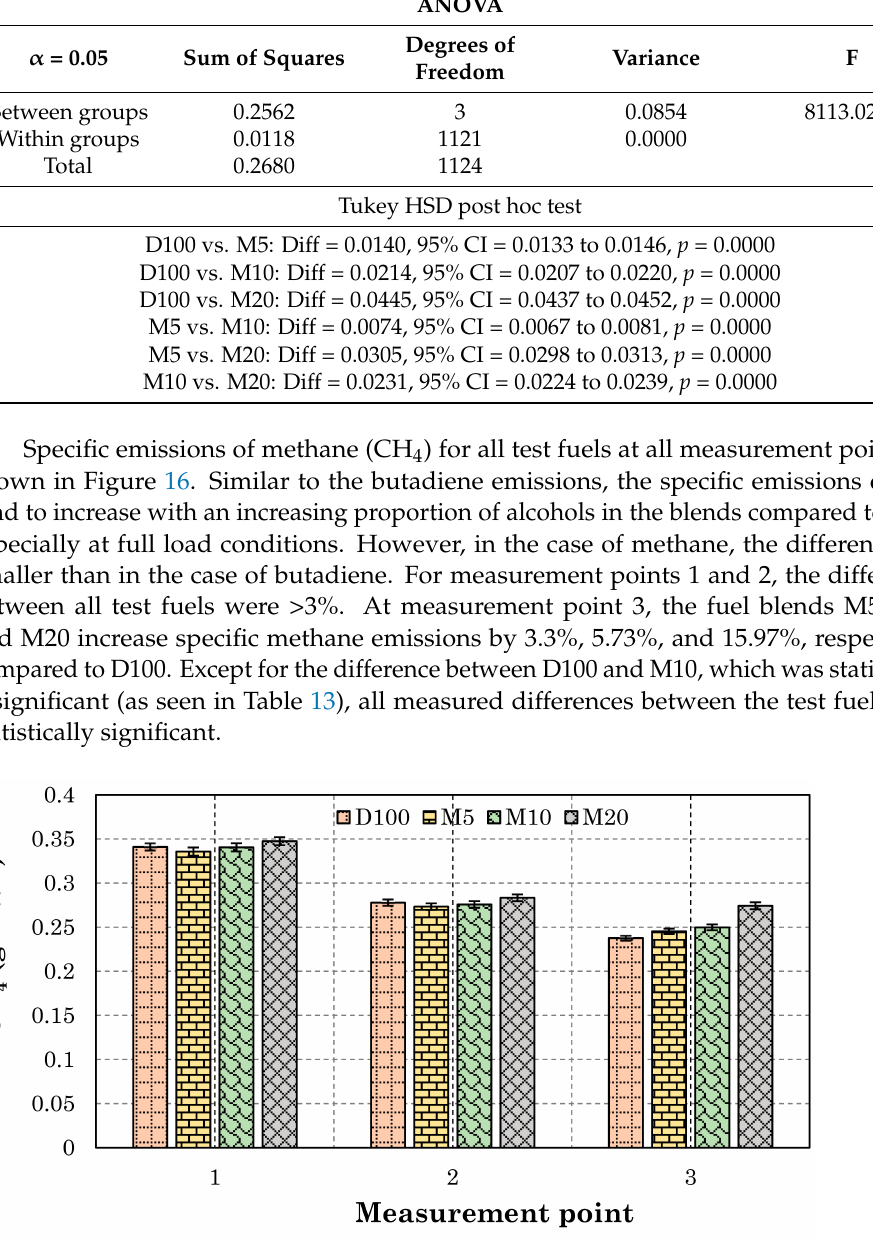
Figure 16. Specific methane emissions for all test fuels at all measurement points (error bars represent the standard